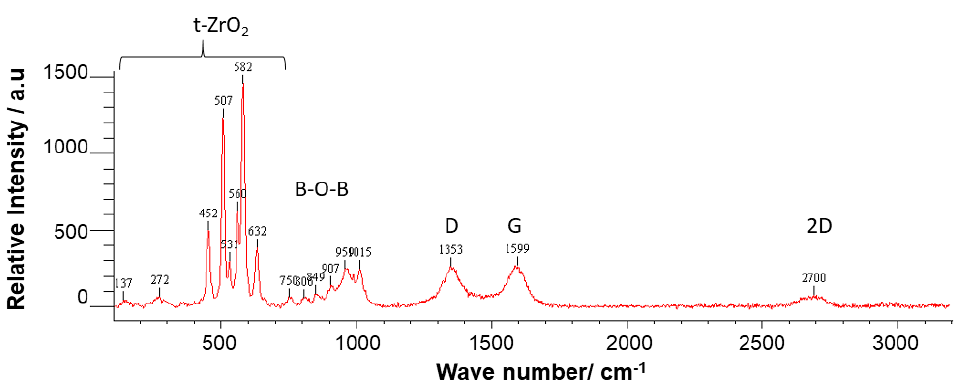
Figure 12. Raman spectra of the ablated front side of the sample using 2% Al based propellant.